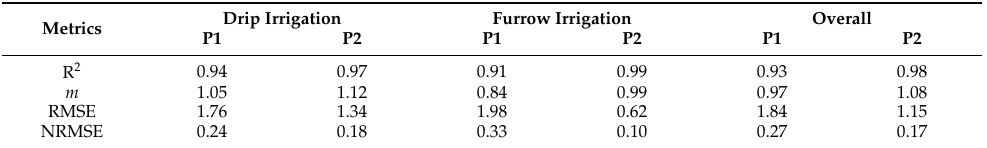
Figure 3. Scatterplot of observed values of the final dry tuber yield (t ha − 1 ) versus simulated data of the water limited module (1st perspective, black triangles) and canopy temperature module (2nd perspective, white triangles) of the SOLANUM model. Triangles facing up and down correspond to drip and furrow irrigation, respectively. Table 4. Metrics’ results for dry tuber yield simulations of the water-limited module (1st perspective (P1)) and canopy temperature module (2nd perspective (P2)) of the SOLANUM model. R 2 : coefficient of determination. m : slope of linear regression. RMSE: root-mean-squared error (in t ha − 1 ). NRMSE: normalized root-mean-squared error (in